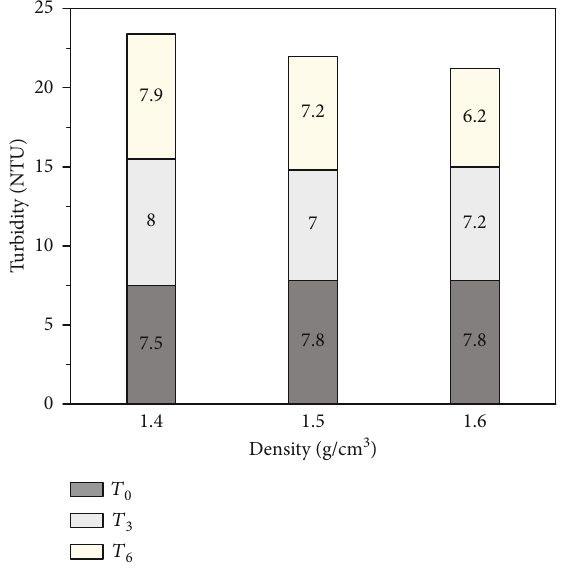
Figure 9: The e ff ect of density on the